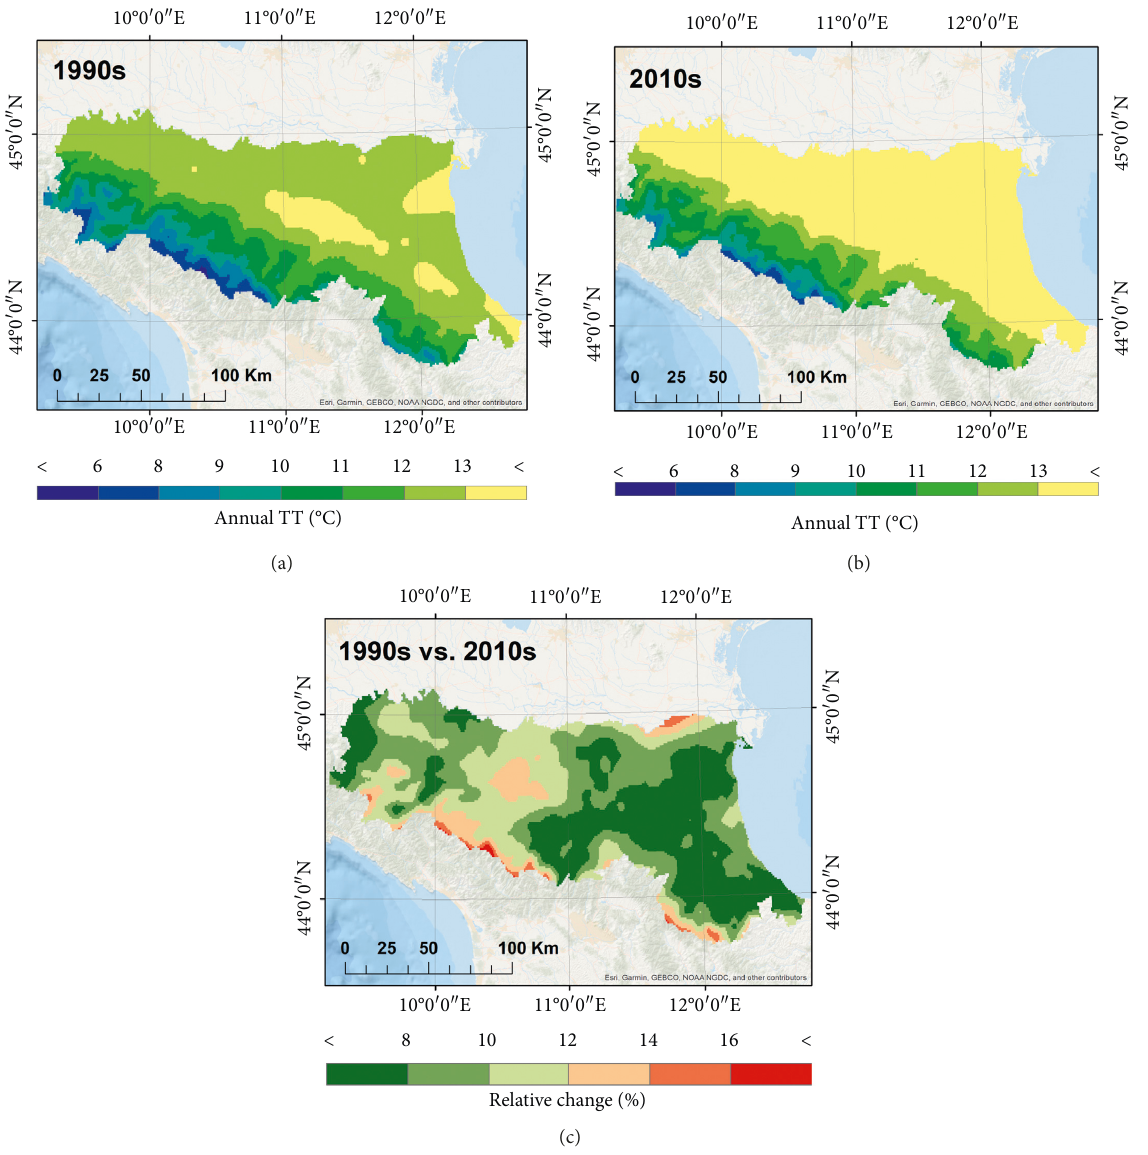
Figure 2: Spatial distribution of mean annual TT. (a) The average of mean annual air TT between 1961 and 1990. (b) The average of mean annual air TT between 1991 and 2015. (c) The relative changes in mean annual TTas a difference between the two time-periods. Background image source: Esri, Garmin, GEBCO, NOAA NGDC, and other